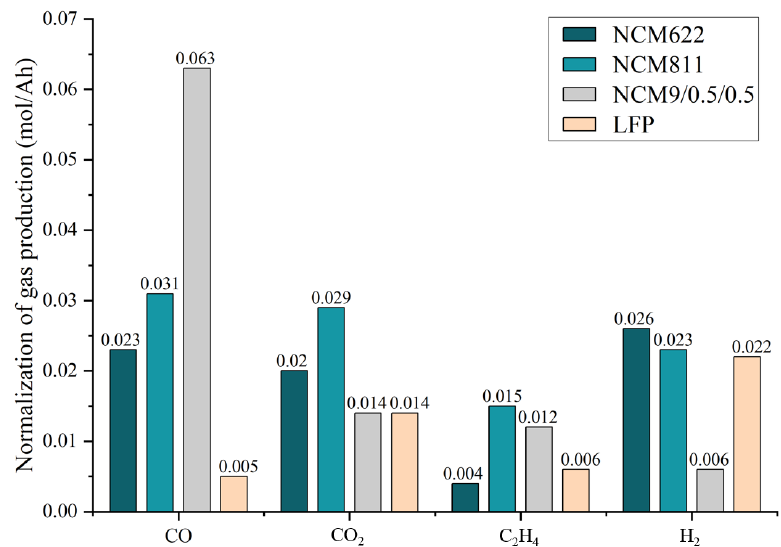
Figure 6. Normalized results of each component gas.